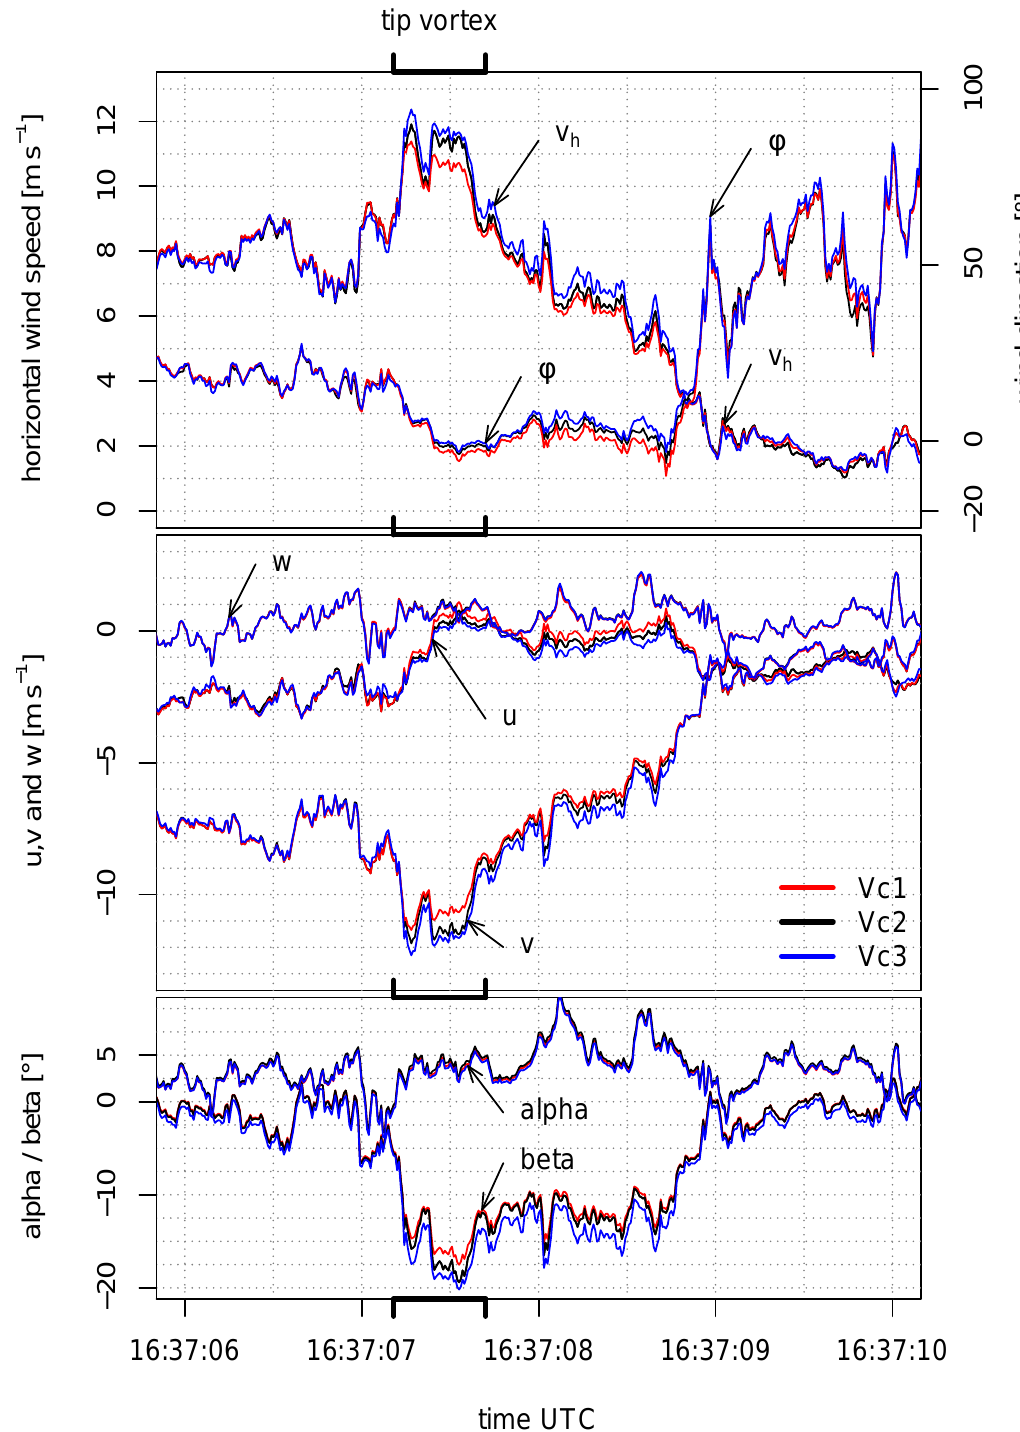
Figure 16. Fraction of the time series of the horizontal windspeed v h and wind direction φ ( top ), the wind vector components u , v and w ( middle ) and the flow angles onto the five-hole probe α and β ( bottom ). All data is plotted for the three calibrations at v c 1 , v c 2 and v c 3 . The position of the tip vortex is